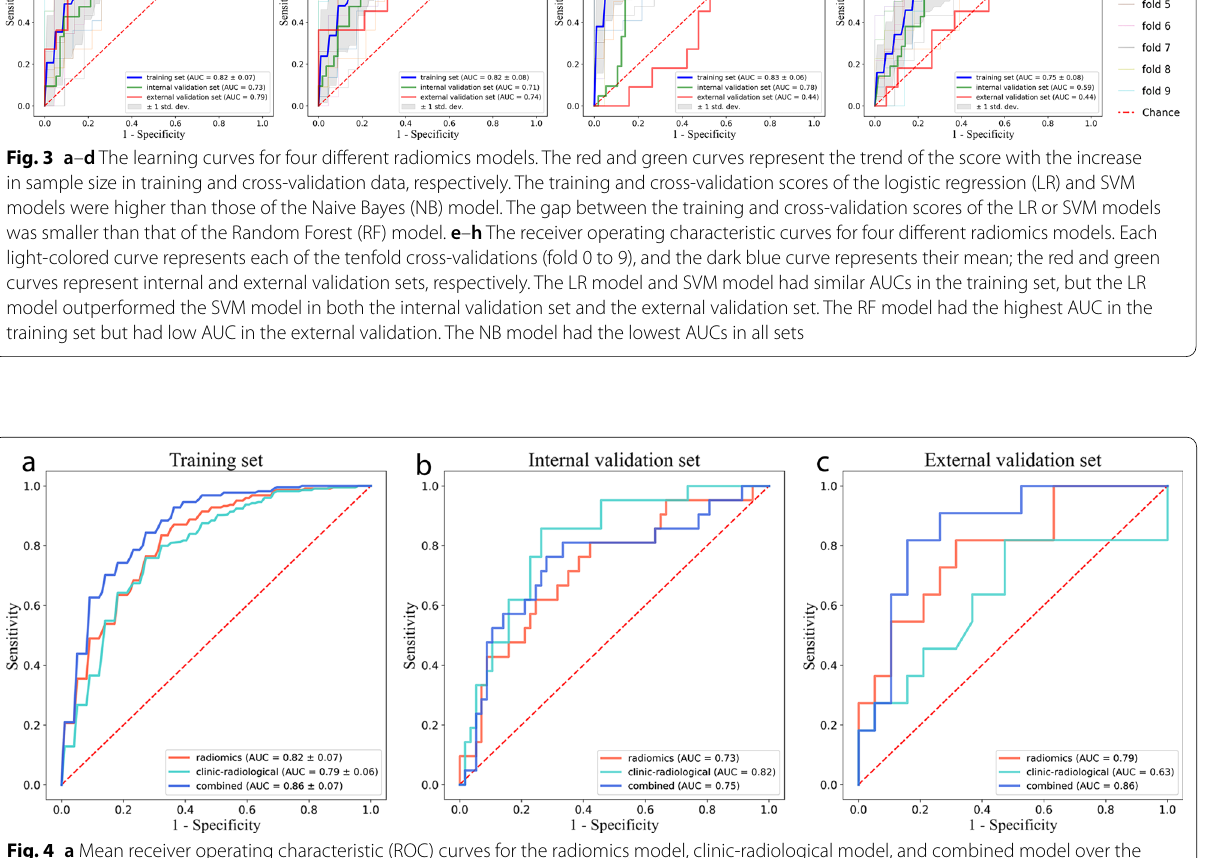
Table 3 Diagnostic performances of different models after tenfold cross-validation iterations Models Specificity Sensitivity PPV